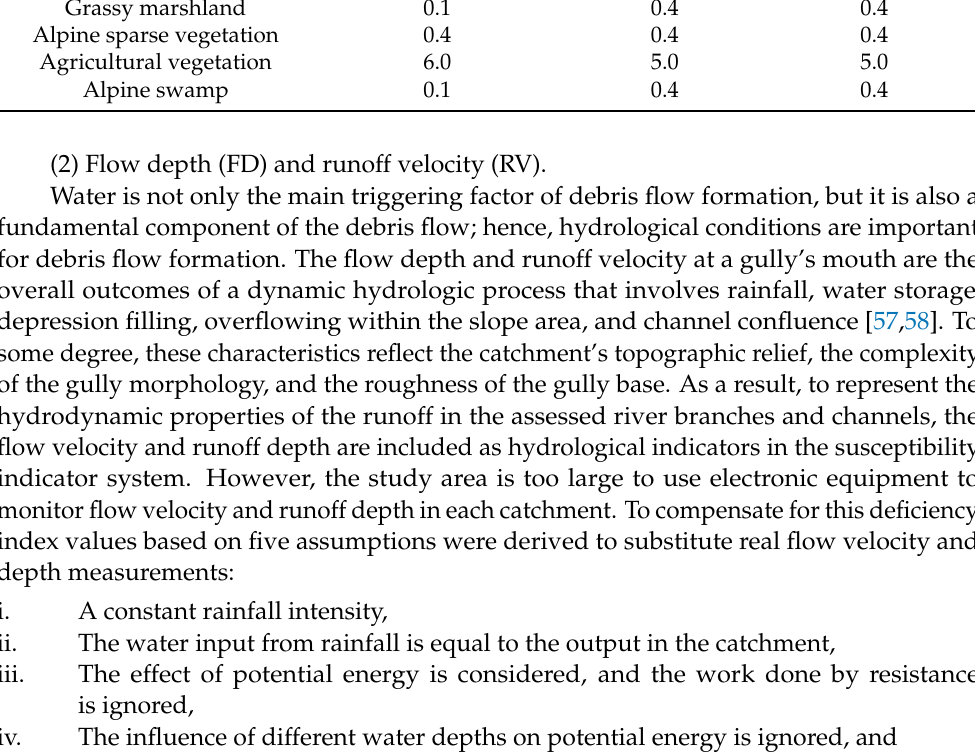
Plant Diameter at Root Breast Height/cm